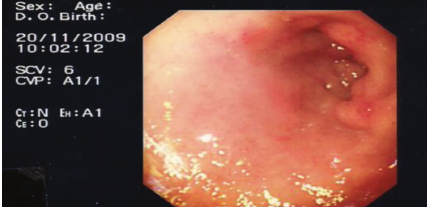
Figure 2: Esophagogastroduodenoscopy showed multiple areas of erythematous patches at the duodenal